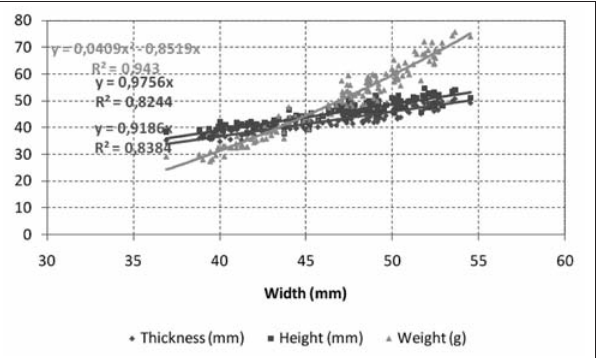
Fig. 13: The connection of the measured data with the width for Hungarian apricot